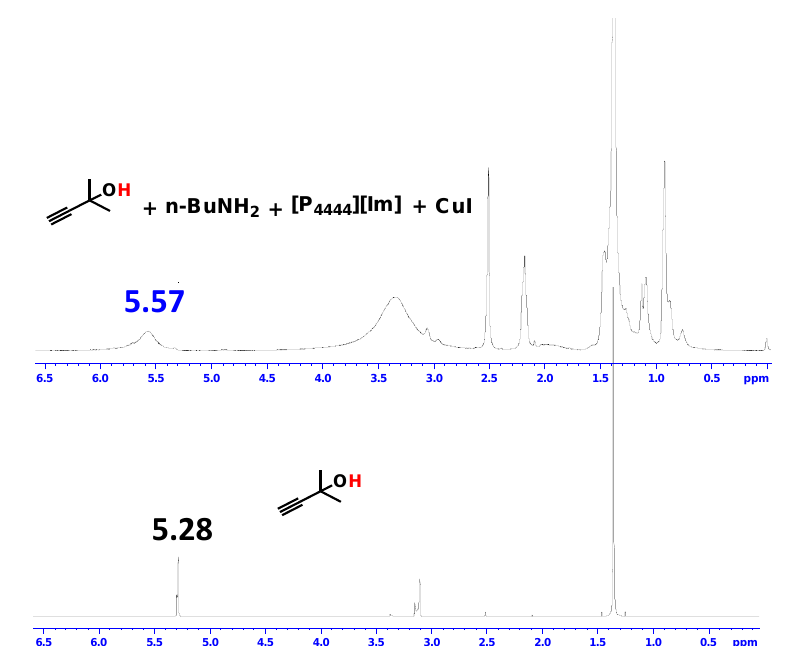
Figure 3. 1 H-NMR spectra of propargylic alcohol, n -BuNH 2 with and without CuI/[P 4444 ][Im] catalyst.